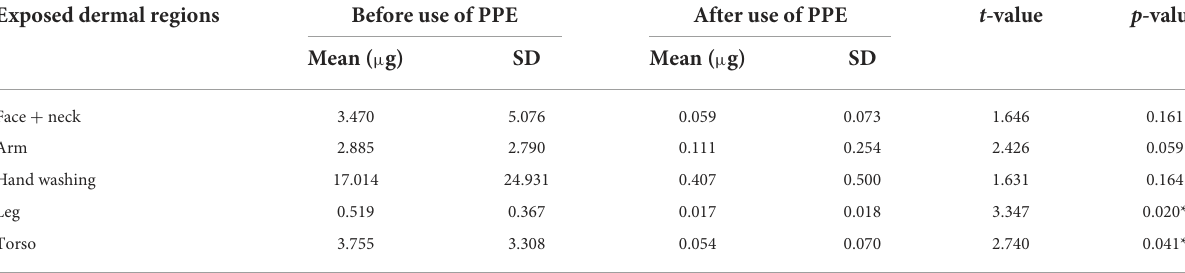
TABLE 9 Association among different exposed dermal regions of the operators. Exposed dermal